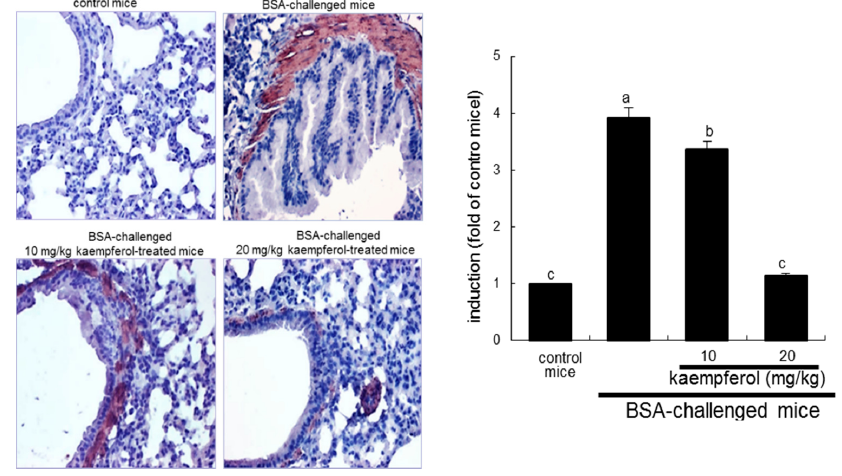
Figure 5. Immunohistochemical analysis showing inhibition of α -smooth muscle actin ( α -SMA) induction in BSA-challenged mouse airway tissues by kaempferol. BSA-sensitized mice on days 0 and 14 were challenged with 5% BSA on days 28, 29 and 30. Airway tissue α -SMA was visualized by staining with 3,3’-diaminobenzidine and counterstained by using hematoxylin. α -SMA was identified as dark brown color and quantified by using an Axiomager optical microscope system ( right panel). Each photograph is representative of four mice. Magnification: 200-fold. Bar graph values (mean ± SEM, n = 4) without a common letter differ, p < 0.05.